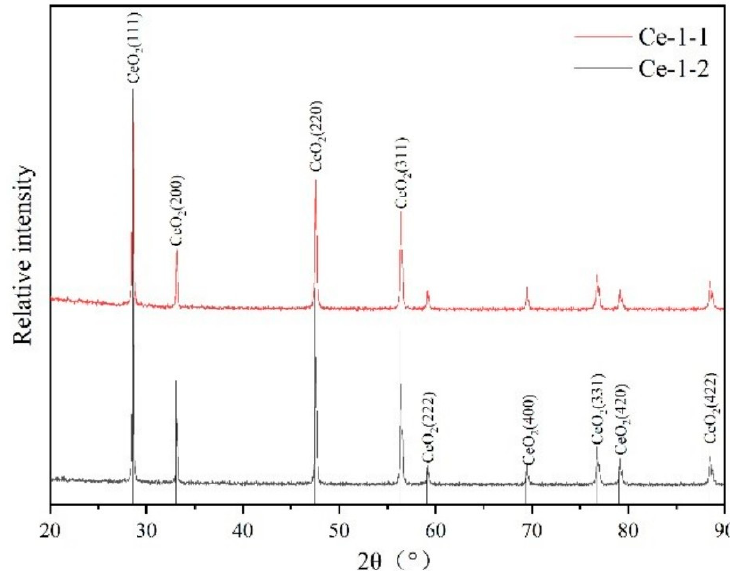
Figure 6. XRD spectra of combustion products.